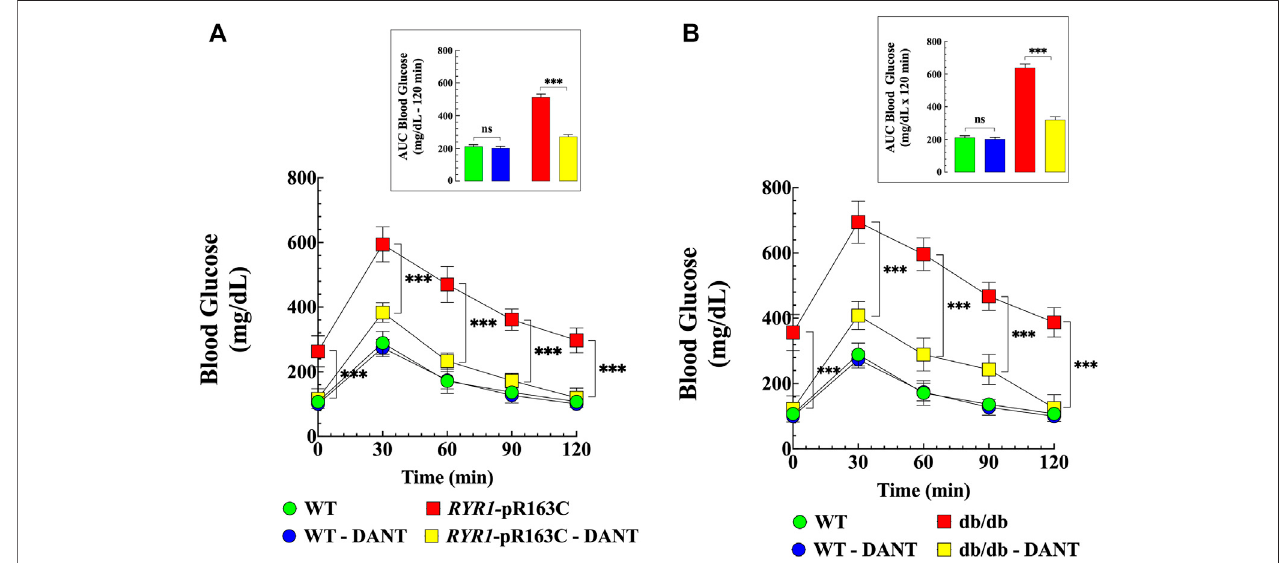
FIGURE 2 | Dantrolene improves glucose tolerance in RYR1-p.R163C and db/db mice. GTT was carried out before and after dantrolene treatment (1.5 mg/kg intraperitoneally daily for 2 weeks) in WT, RYR1 -p.R163C, and db/db mice. Dantrolene signi fi cantly reduced fasting glycemia in RYR1 -p.R163C (A) and db/db mice (B) and improved response to glucose load at all times studied in RyR1 -p.R163C and db/db compared to untreated mice. The insets in Figures (A, B) represent the area under the curve before and after dantrolene treatment for 120 min. The results represent the mean ± S. D from n mice = 5 per genotype. Statistical analysis was performed as described above. ns = non signi fi cative; *** = p <